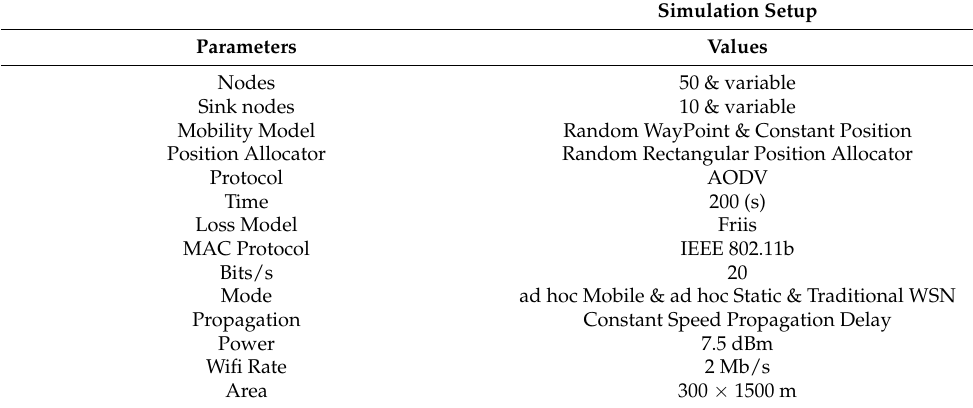
Table 2. Setting Simulation